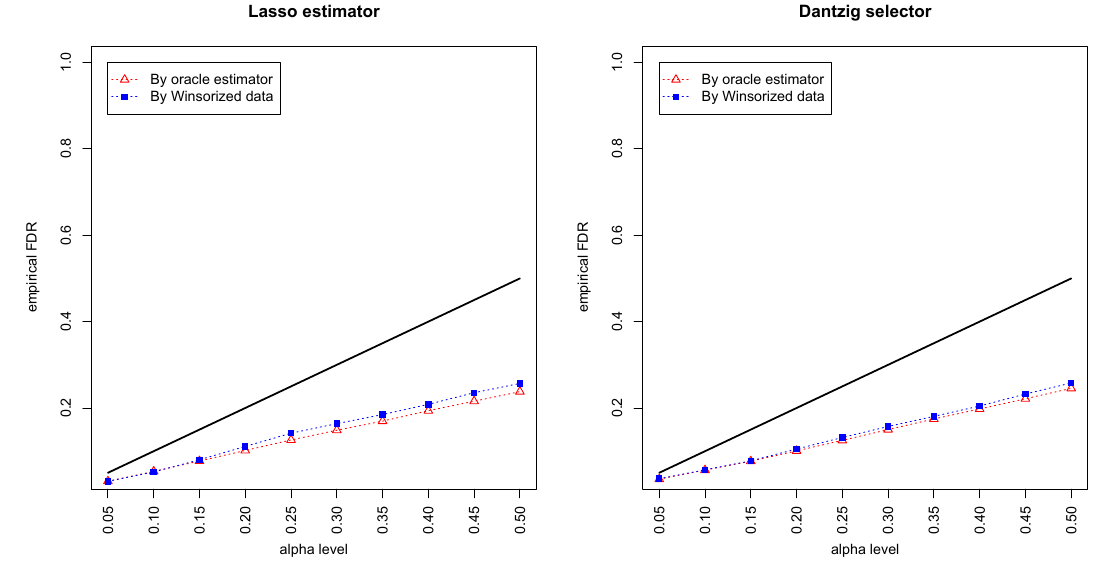
Figure 2. Empirical FDRs (eFDRs) by oracle data and Winsorized imputations under the Erd˝os–Rényi (ER) graph setting. The x -axis represents the desired FDR levels from 0.05 to 0.5, and the solid line is y = x .